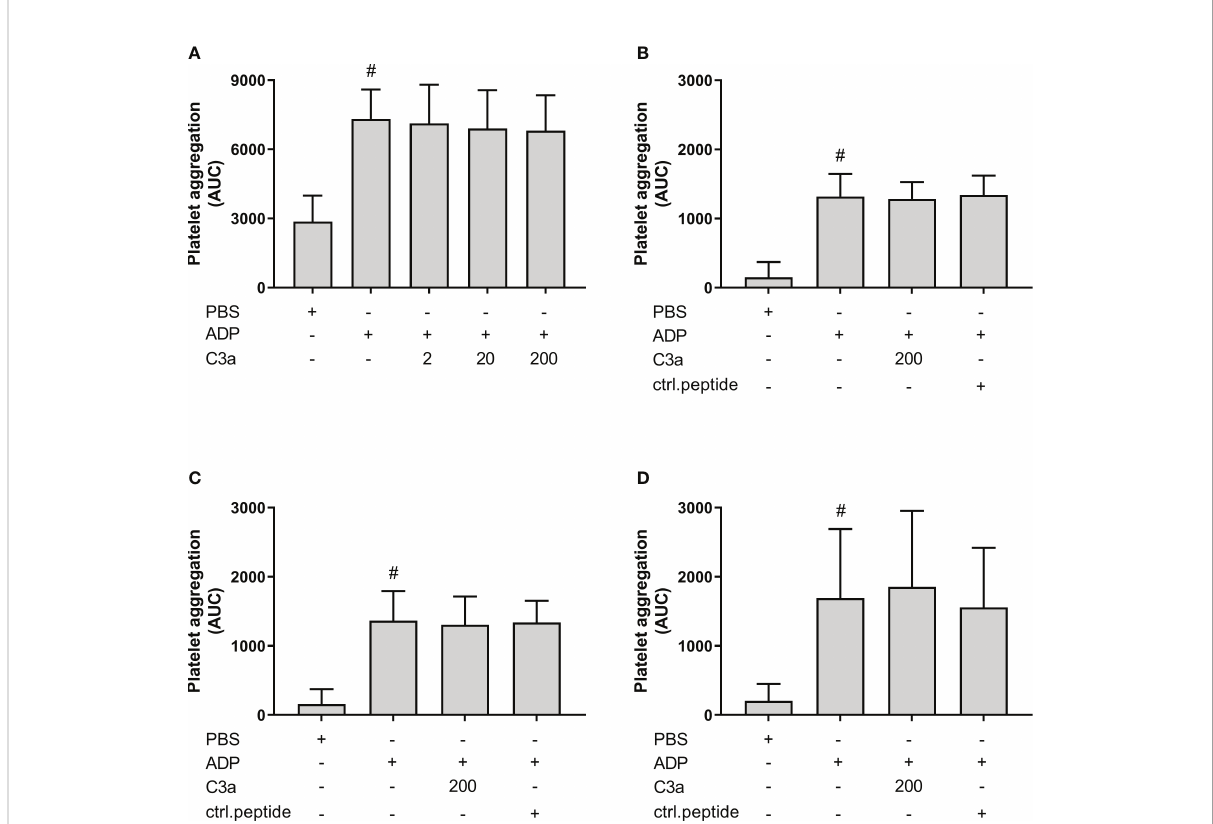
FIGURE 8 The effect of C3a addition on adenosine diphosphate (ADP)-induced platelet aggregation measured on Multiplate ® impedance aggregometry with whole blood and platelet-rich plasma (PRP) in different anticoagulants. To hirudin whole blood was added phosphate-buffered saline (PBS) control, ADP (2 µM), and C3a (2, 20 and 200 nM) (n = 6) ( A ). Hirudin PRP with PBS control, ADP (2 µM), C3a (200 nM) or control peptide (200 nM) (n = 4) ( B ). ACD PRP with PBS control, ADP (2 µM), C3a (200 nM) or control peptide (ctrl.peptide 200 nM) (n = 6) ( C ). Citrate PRP with PBS control, ADP (2 µM), C3a (200 nM) or control peptide (200 nM) (n = 6) ( D ). Results are given as the area under the curve (AUC), using mean ± standard deviation. #; p < 0.05 analyzed using a paired Student ’ s t-test between the samples with and without ADP, and Dunnett ’ s multiple comparisons test, comparing ADP-activated samples with and without inhibitors or